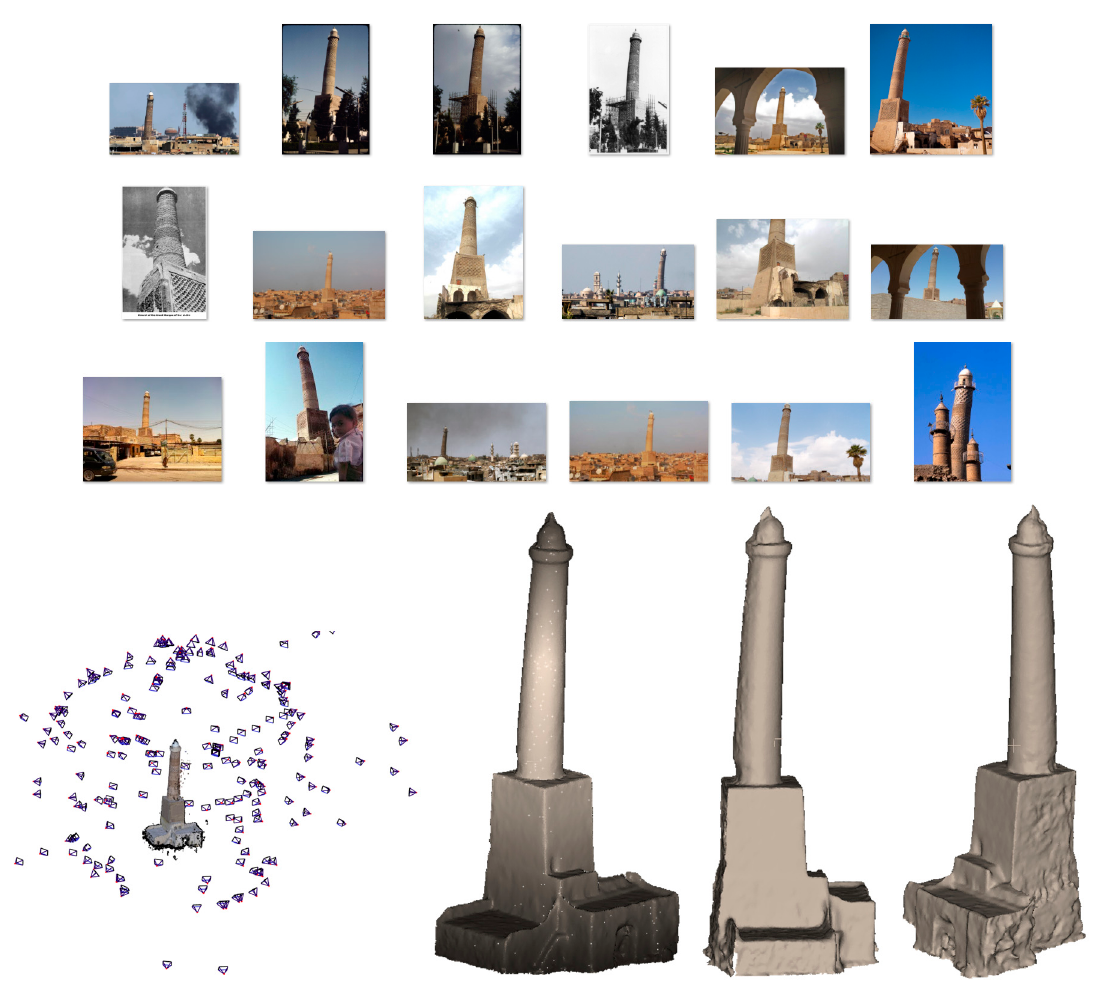
Figure 16. The derived image-based 3D model (.stl) of Al-Hadbaa minaret.